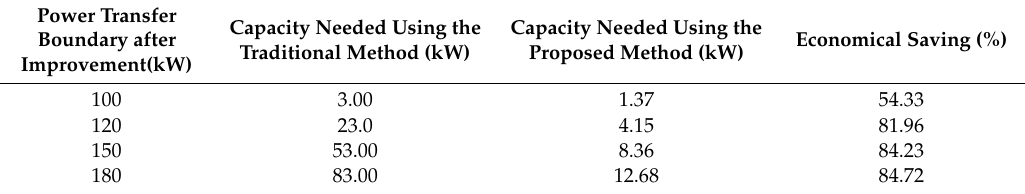
Table 2. Power capacity comparison of DC / DC converter of the ESS.